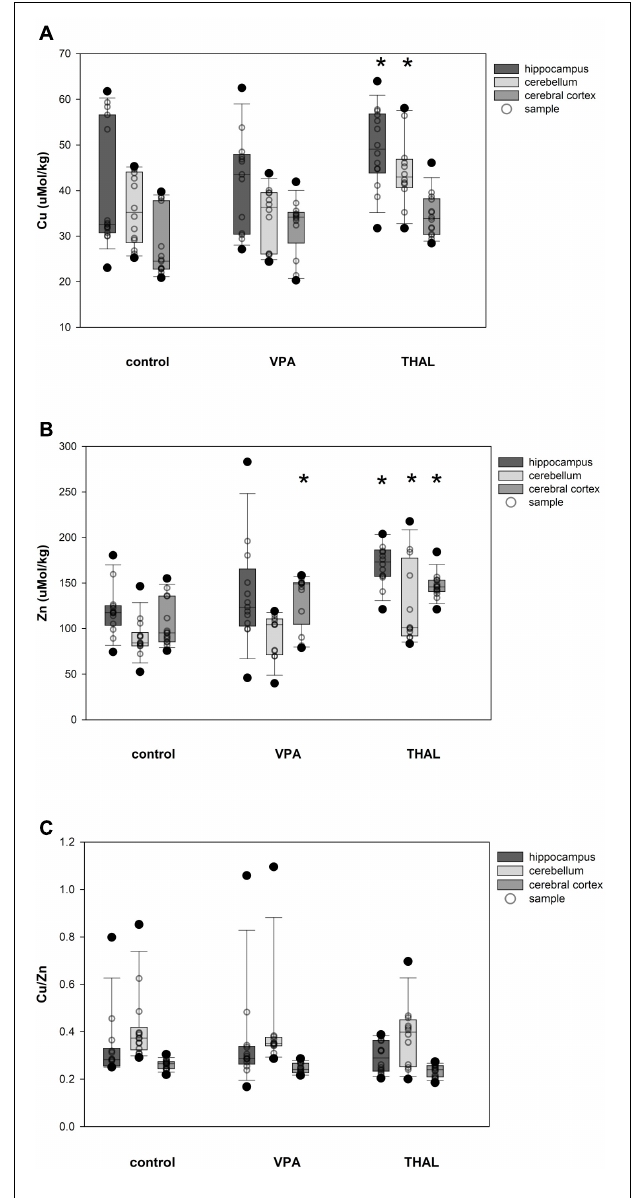
FIGURE 4 | Box and Whiskers plot of changes in Cu (A) , Zn (B), and Cu/Zn (C) levels in male rats in parts of brain: hippocampus, cerebellum and cerebral cortex, measured using the ICP-MS method. The obtained results are expressed in concentration µ M/kg wet tissue (A,B) . The number of animals used in this experiment was: n = 15 – control group, n = 12 – VPA-treated rats, and n = 12 – THAL-treated animals; (*) represents results statistically significant vs. control, p < 0.05, two-way ANOVA followed by Holm-Sidak corrections; box containing 50% of results that fell in the range between 25% (bottom line) and 75% (top line) – IQR (InterQuartile Range), (–) median value, whiskers – min and max values, ( • ) – outliers ( ± 1.5 × IQR), ( ◦ ) – individual